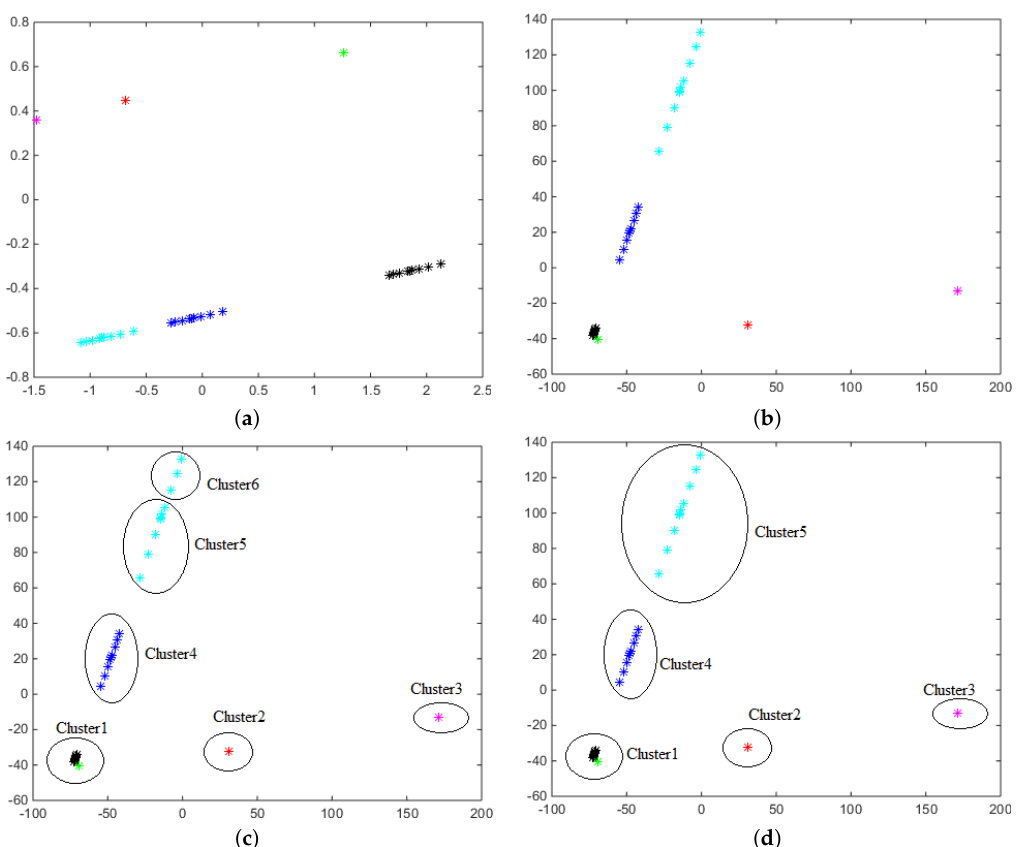
Figure 7. MDS applied to the distance matrices: ( a ) using d new , ( b ) using d 2 . The ten initial spirals are marked in green and the ten initial circumferences are represented with black asterisks. The enlarged spirals are plotted in red (factor 50) and magenta (factor 250) and the enlarged circumferences are plotted in blue (factor 50) and cyan (factor 250). The clusters obtained on d 2 are plotted: ( c ) using k -means algorithm with k = 6, ( d ) using DBSCAN and k -means, k =